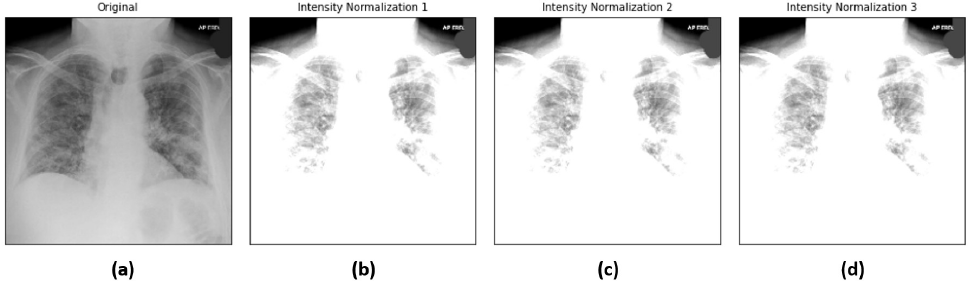
Figure 7. Sample chest X-ray images: ( a ) original, ( b ) intensity normalization ( mean = 0.485 and variance = 0.229 ) , ( c ) intensity normalization ( mean = 0.456 and variance = 0.224 ) and ( d ) intensity normalization ( mean = 0.406, variance = 0.225 )